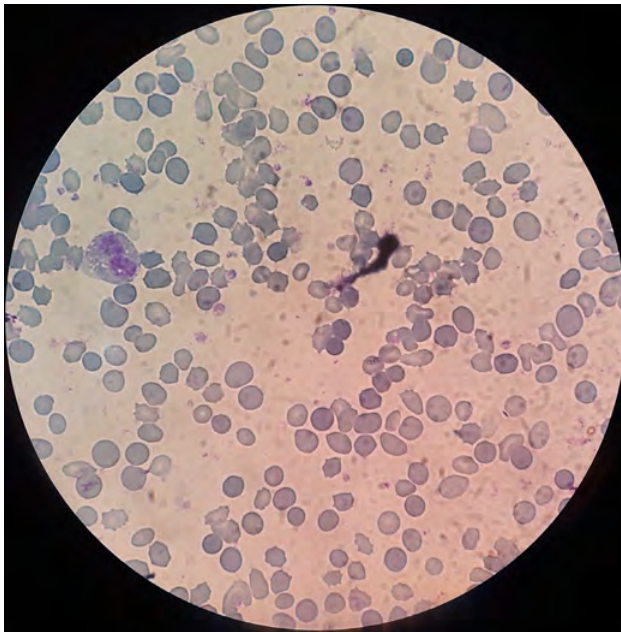
Fig 1 : Moderately distributed spherocytes in peripheral blood smear